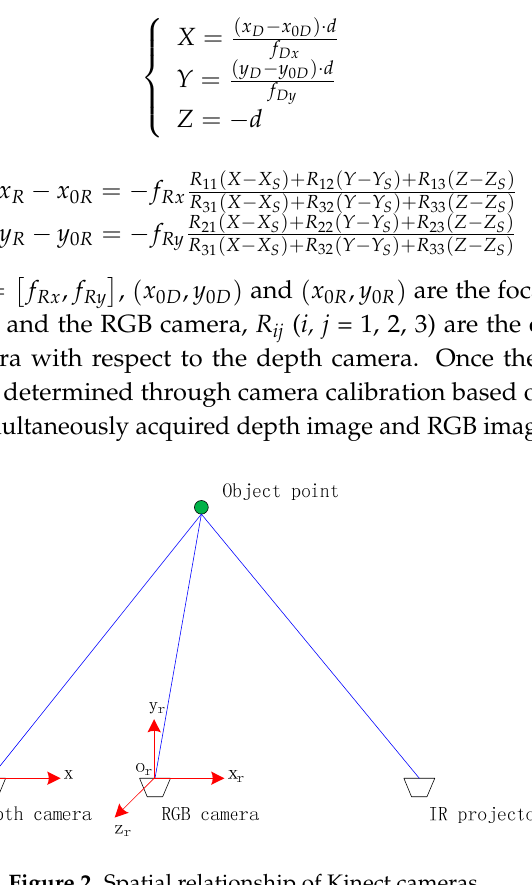
Figure 2. Spatial relationship of Kinect cameras.